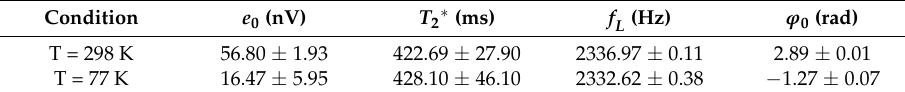
Table 2. Fitted parameters and the confidences.